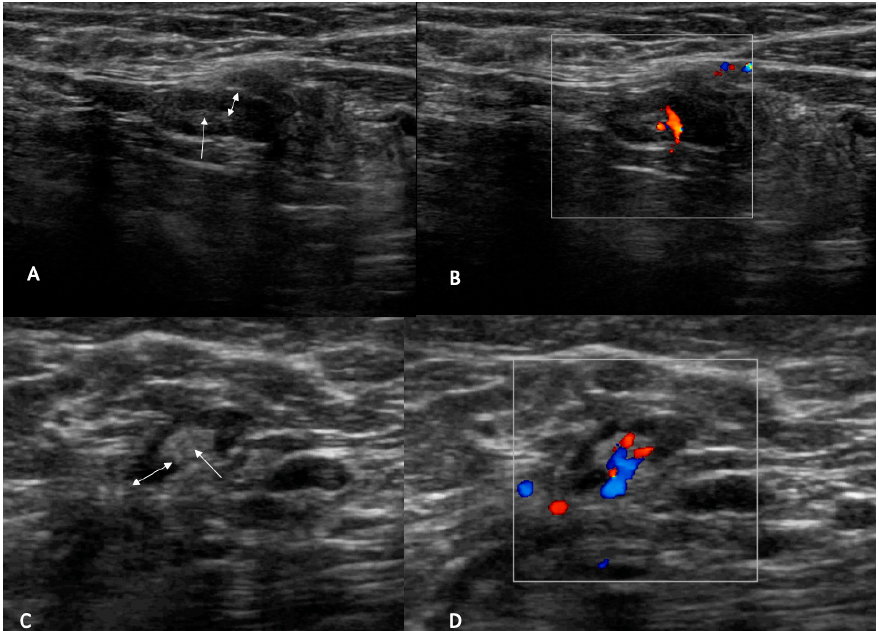
Figure 2. UN2: ( A – D ) B-mode sonogram image shows an oval node with uniform cortical thickening (<3 mm), centrally placed fatty and vascular hilum (color flow ultrasound).  UN 3: 3 mm cortex with uniform cortical thickness, centrally placed fatty and vascular hilum (color flow ultrasound), oval shape (preserved the bipolar ratio of diameters) (Figure 3).